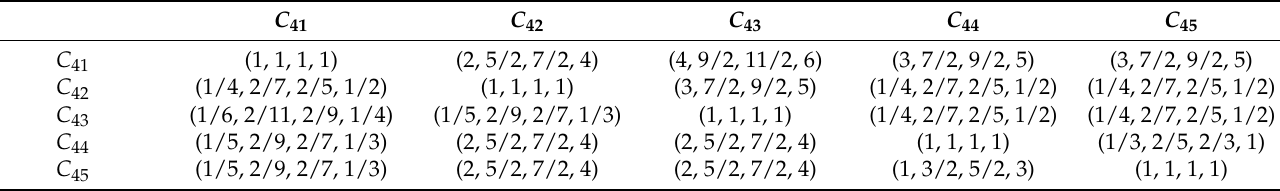
Table A5. Pair-wise comparison matrix of the sub-factor: material ( C 4 ).